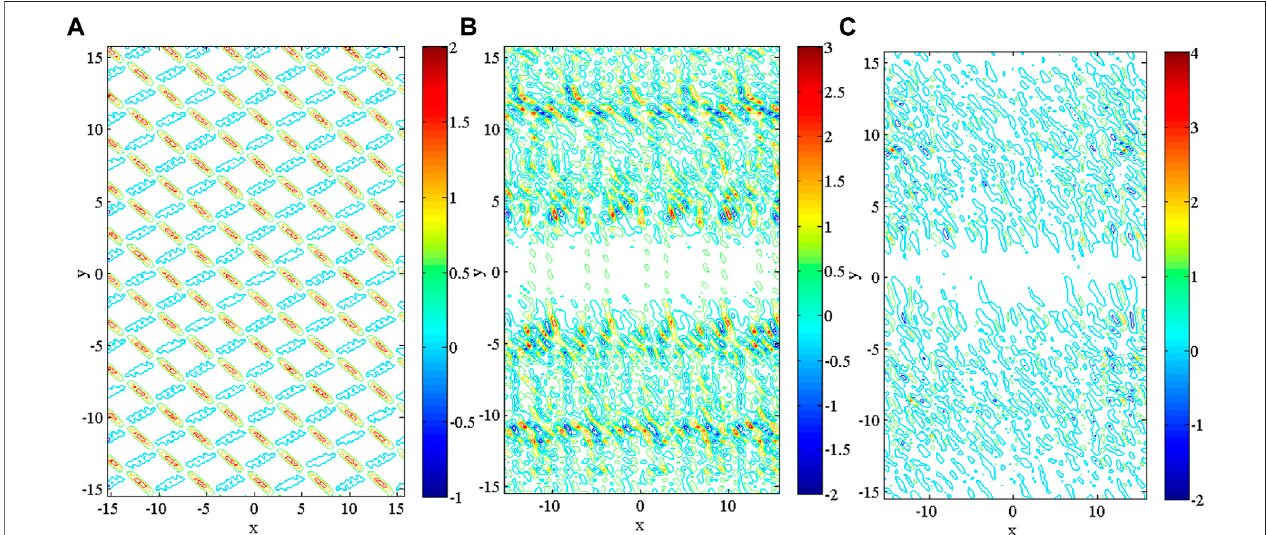
FIGURE 13 | DAW-normalized current density for different z, (A) z = 0, (B) z = 2, and (C) z = 5 when the magnetic islands and perturbation in the background density are present. “ Reproduced from [(Sharma et al., 2020), Physics of Plasmas , 27 , https://doi.org/10.1063/1.5142893], with the permission of AIP Publishing. ”